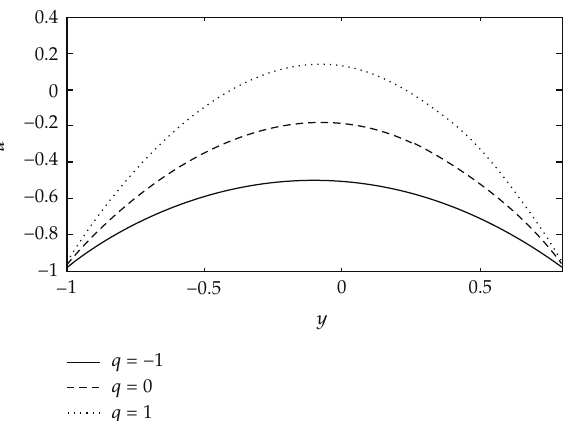
Figure 9: Axial velocity versus y at α (cid:9) 0 . 05, a (cid:9) 0 . 2, b (cid:9) 0 . 6, d (cid:9) 0 . 8, ε (cid:9) 0 . 2, λ 1 (cid:9) 1, Da (cid:9) 1, x (cid:9) 0, and φ (cid:9) π/